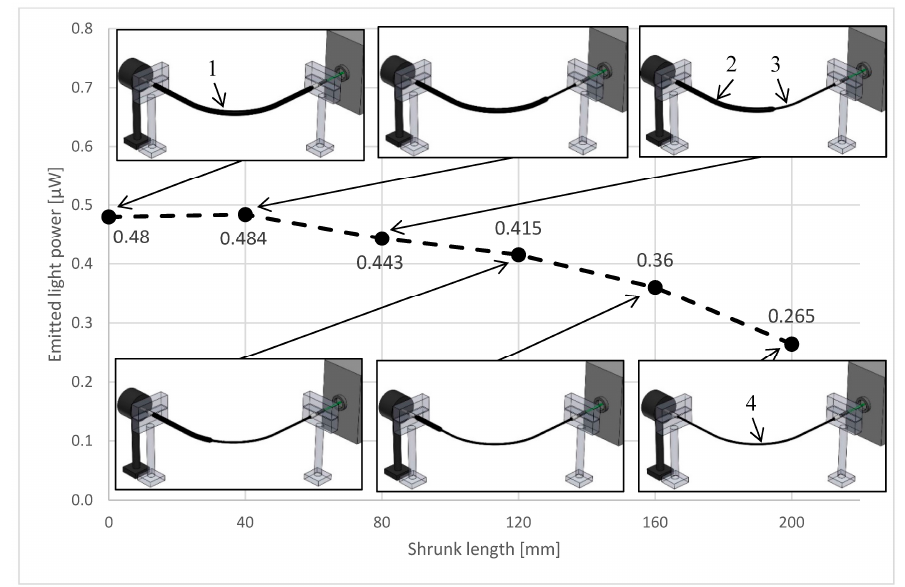
Figure 2. The effect of compression on emitted light power (1—reinforcing fiber bundle in the unshrunk shrink ‐ on tube, 2—unshrunk shrink ‐ on tube section, 3—shrunk shrink ‐ on tube section, 4—shrunk shrink ‐ on tube).